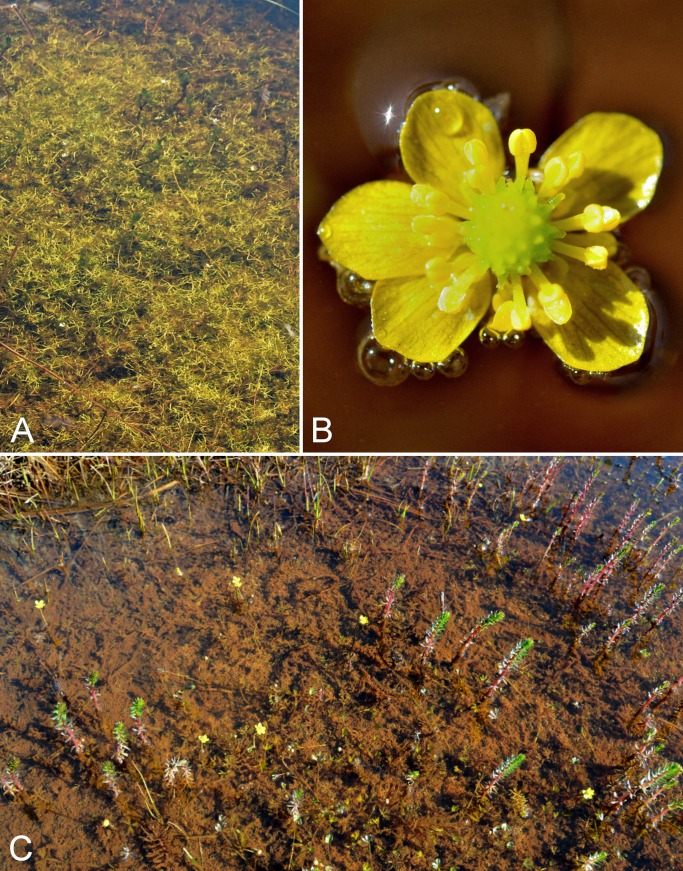
Ranunculus gmelinii subsp. gmelinii and Ranunculus hyperboreus.Ranunculus gmelinii subsp. gmelinii: (A) habitat, Saarela et al. 3697. Ranunculus hyperboreus: (B) inflorescence, Saarela et al. 3696. (C) Habitat, Saarela et al. 3696. Photographs by J. M. Saarela (A) and R. D. Bull (B, C).